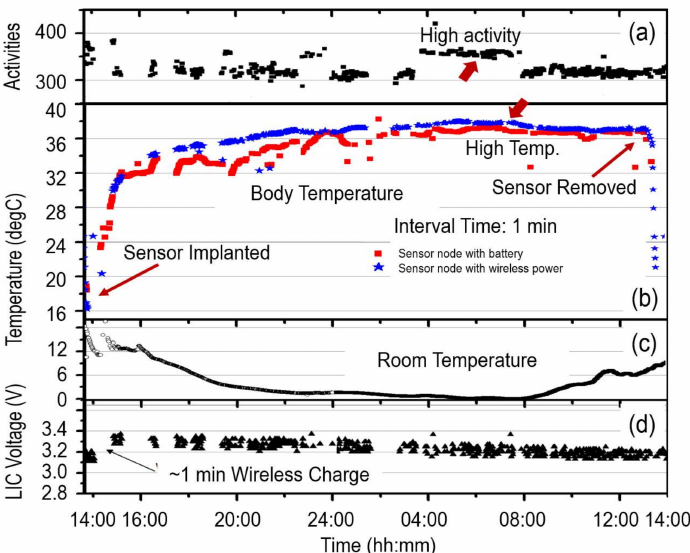
Figure 7. Evaluation results after implanting the second and third prototype sensor nodes into a wagyu (Japanese cow): calculated activities form the measured data of the accelerometer ( a ); measured body temperature ( b ); measured room temperature ( c ); and measured voltage of the LIC ( d ) for the duration of a day after